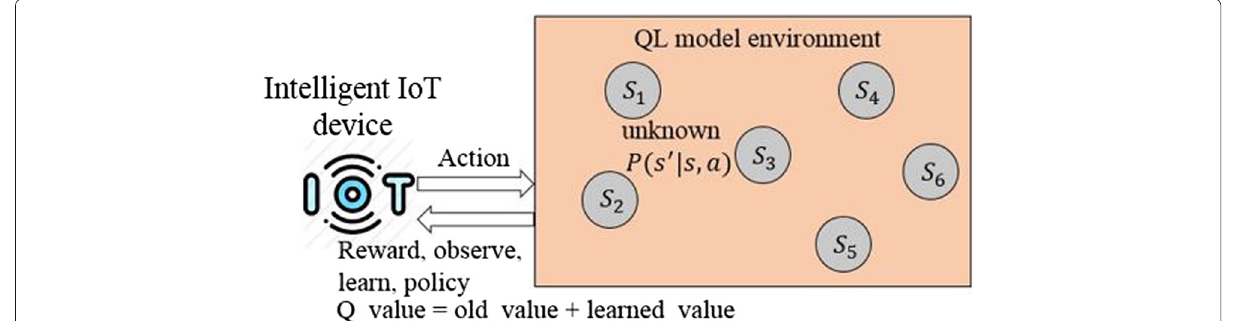
Fig. 4 Q-learning system environment with its